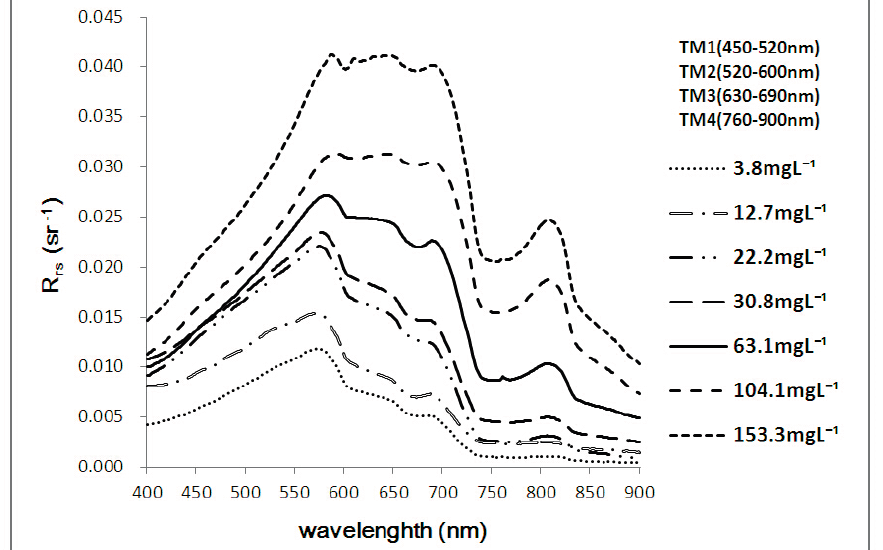
Figure 5. Remote sensing reflectance (sr − 1 ) corresponding to different wavelengths (nm) for selected SSC levels. Each curve at a given SSC level shows the relationship between the spectral ranges and reflectance